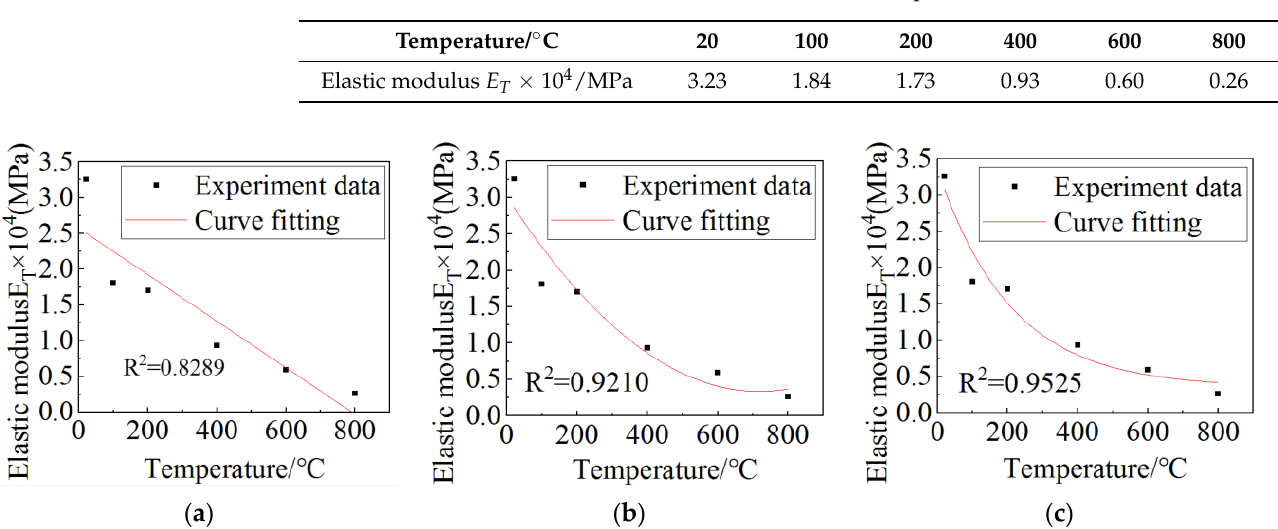
Table 3. Elastic modulus of concrete after different heated temperatures.